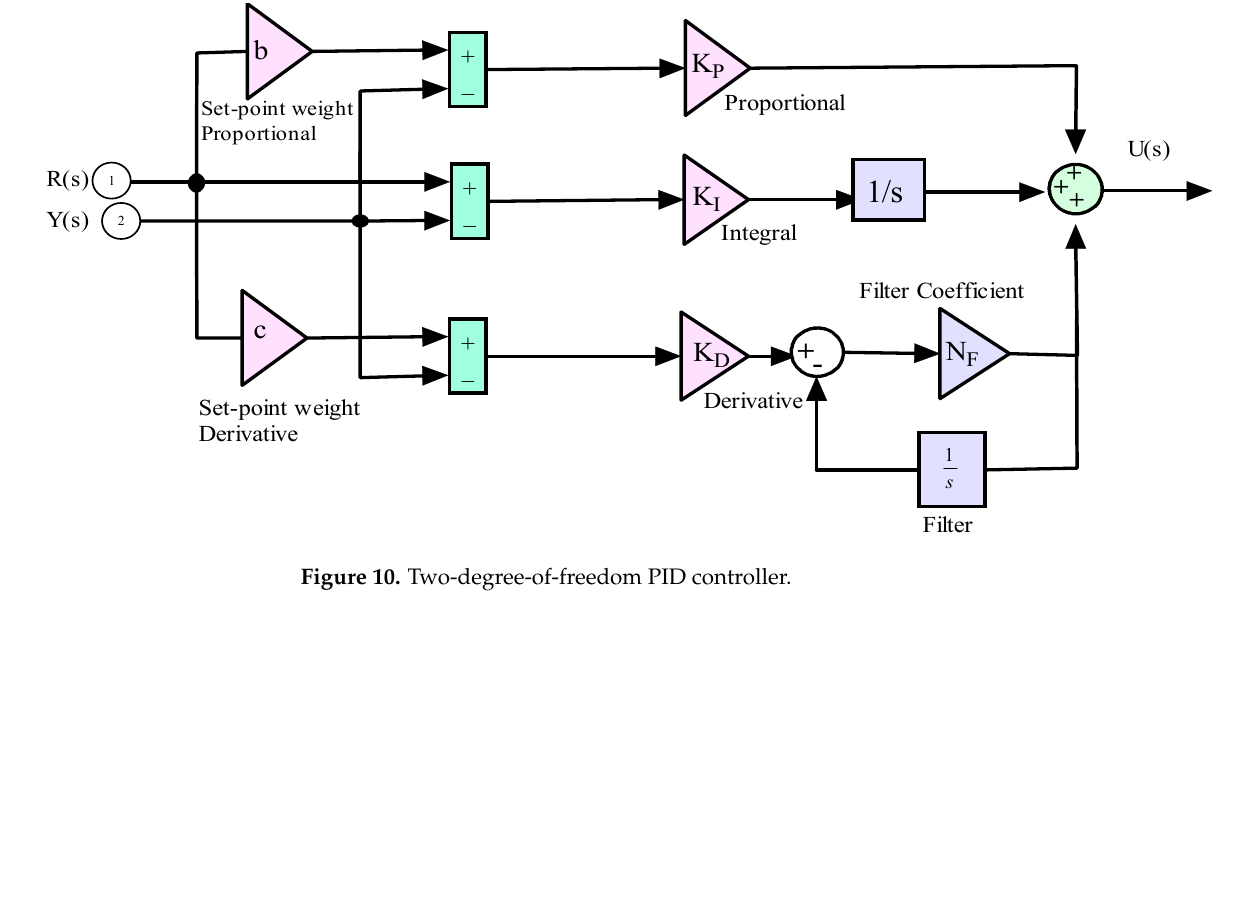
Figure 11. Three-degree-of-freedom PID controller. Table 4. Merits and demerits of controllers Controllers